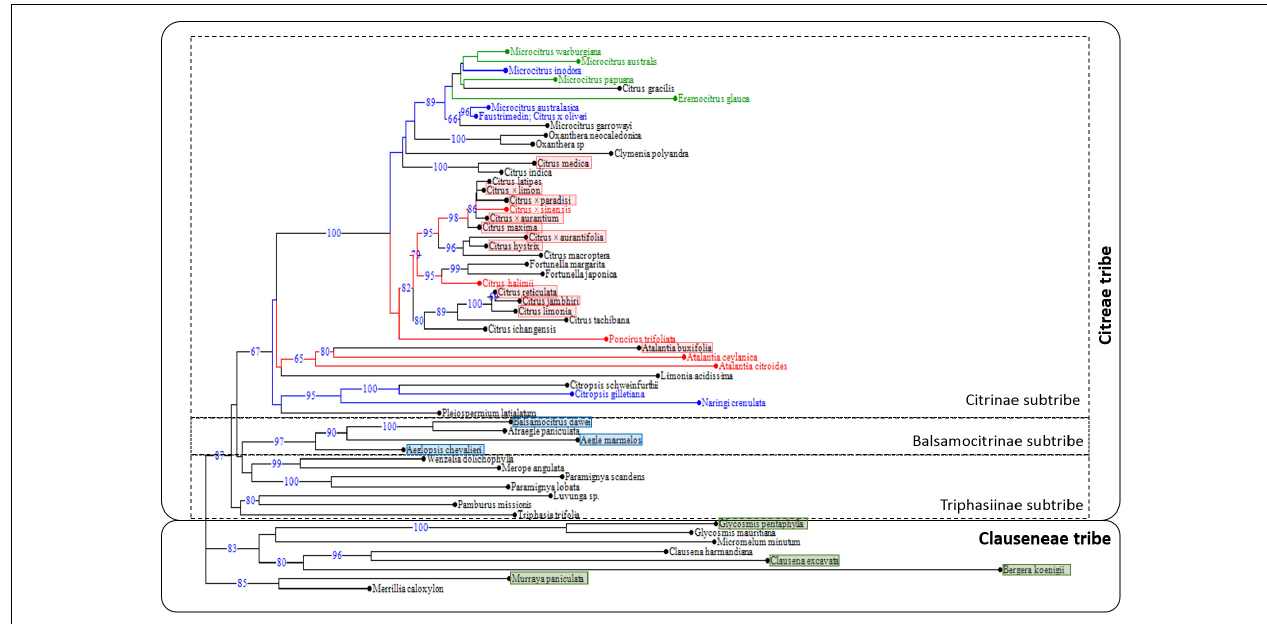
FIGURE 4 | Distribution on the phylogenetic tree of the Aurantioideae sub-family (NJ tree based on eight chloroplast genome fragments) based on accession responses to Las challenge inoculation according to this study (red text: susceptible, blue text: partially resistant, green text: full resistant) and Ramadugu et al. (2016) (red rectangle: susceptible –categories 6 to 8; blue rectangle: tolerant –categories 3, 4; green rectangle: resistant –categories 1,